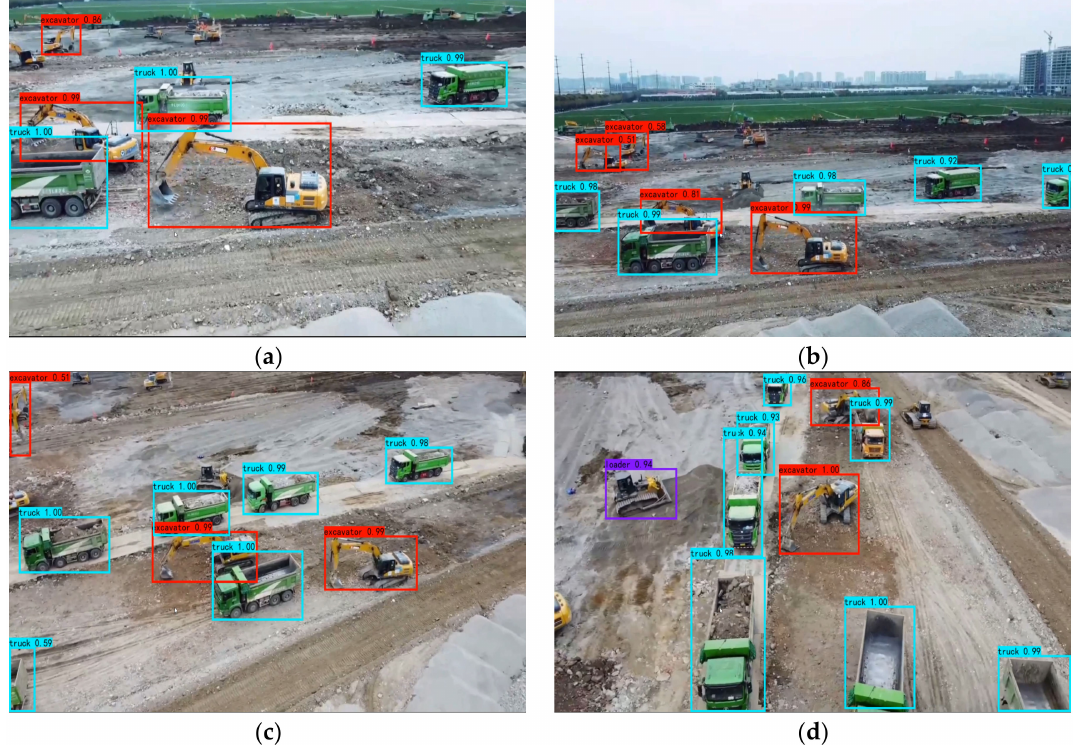
Figure 10. Example improved model detection results for video 2 under occlusions. ( a ) Frame 527, ( b ) Frame 581, ( c ) Frame 779, ( d ) Frame